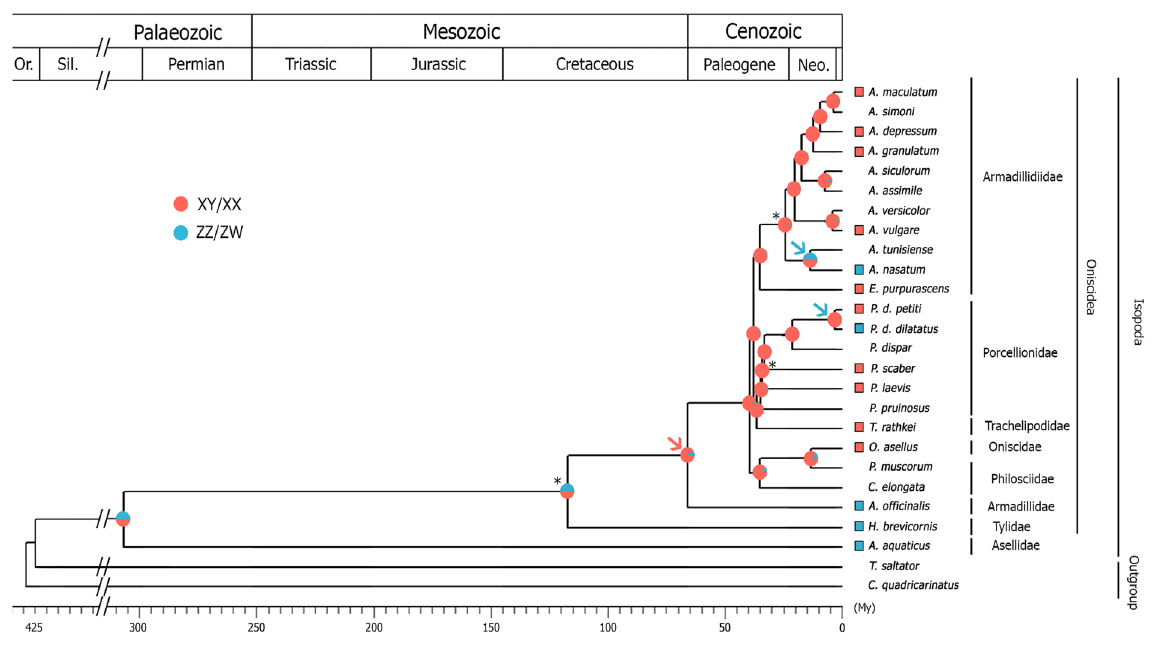
Figure 2. Ancestral state reconstruction of sex determination systems in terrestrial isopod crustaceans, based on a Bayesian phylogenetic analysis using 88 molecular markers. The reconstruction is based on the one-parameter equal rates model (“ER” model), considering the A . assimile sex determination system as unknown. Pie charts on nodes show the probability of the ancestral state at each node, calculated from 1,000 stochastic mappings. Branch length is scaled to time, with nodal ages corresponding to median posterior estimates. * Denote the calibration points. Red and blue squares at branch tips indicate a ZZ/ZW and XY/XX sex determination systems, respectively. Transitions of sex determination systems determined by parsimony ancestral state reconstruction are outlined with arrows (one red arrow for a transition from XY/XX system to ZZ/ZW, and two blue arrows for transitions from ZZ/ZW to XX/XY systems). Isopod family names and higher taxonomic ranks are shown on the